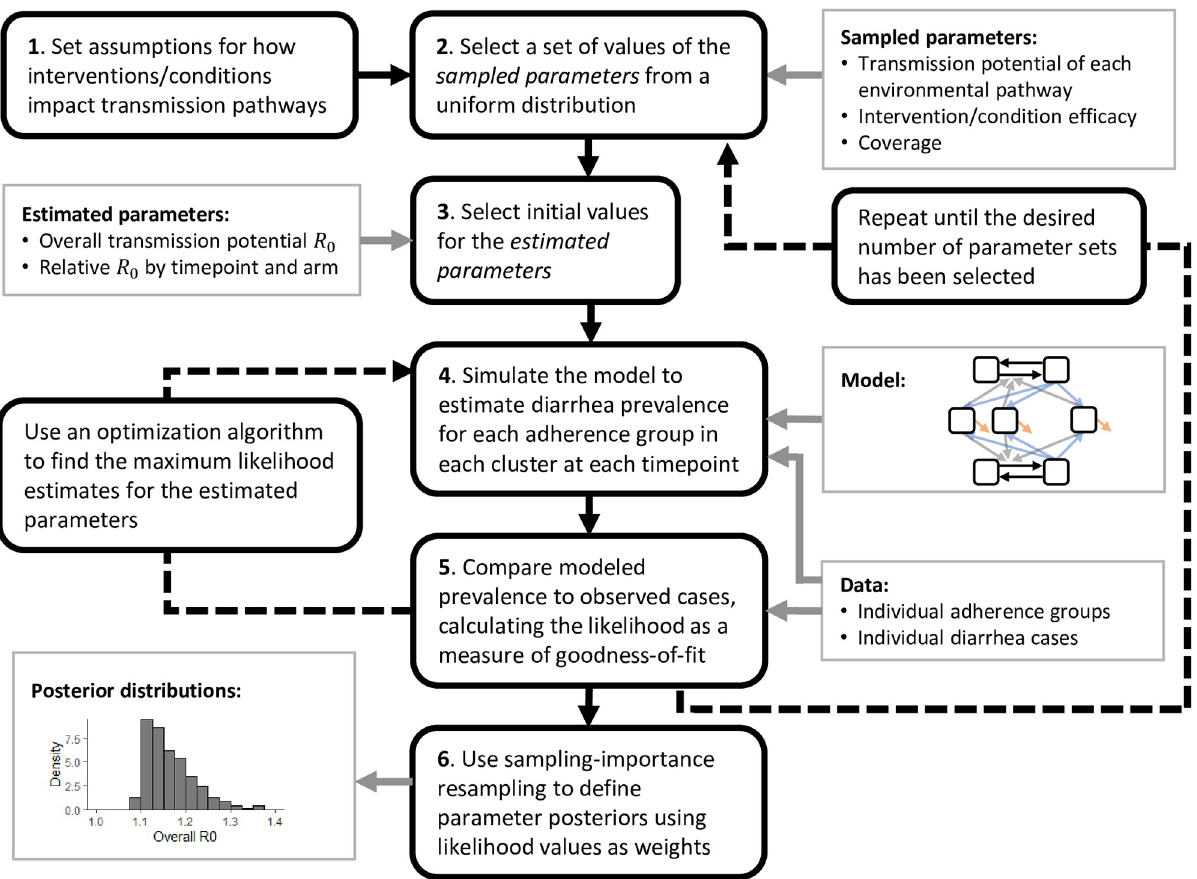
Fig 3. Schematic. Schematic of the hybrid sampling–estimation approach to estimating model parameters from Water, Sanitation, and Hygiene (WASH) randomized controlled trials (RCT) data.